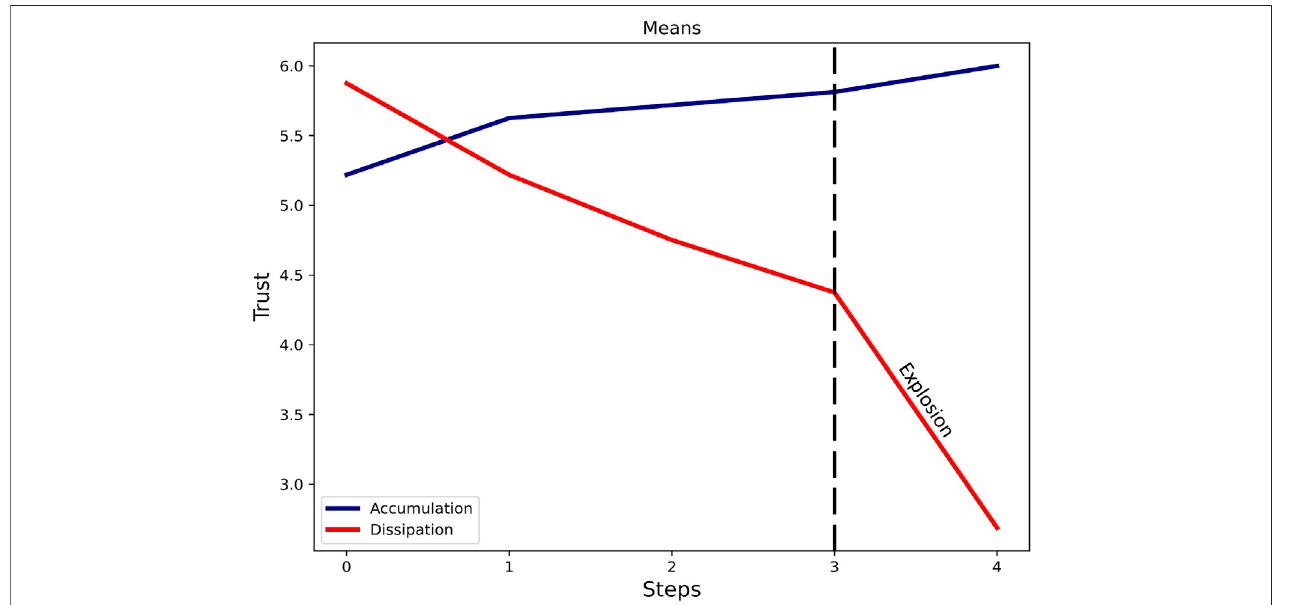
FIGURE 7 | Dynamic trust development. Almost doubly stronger dynamics in dissipation compared to accumulation.